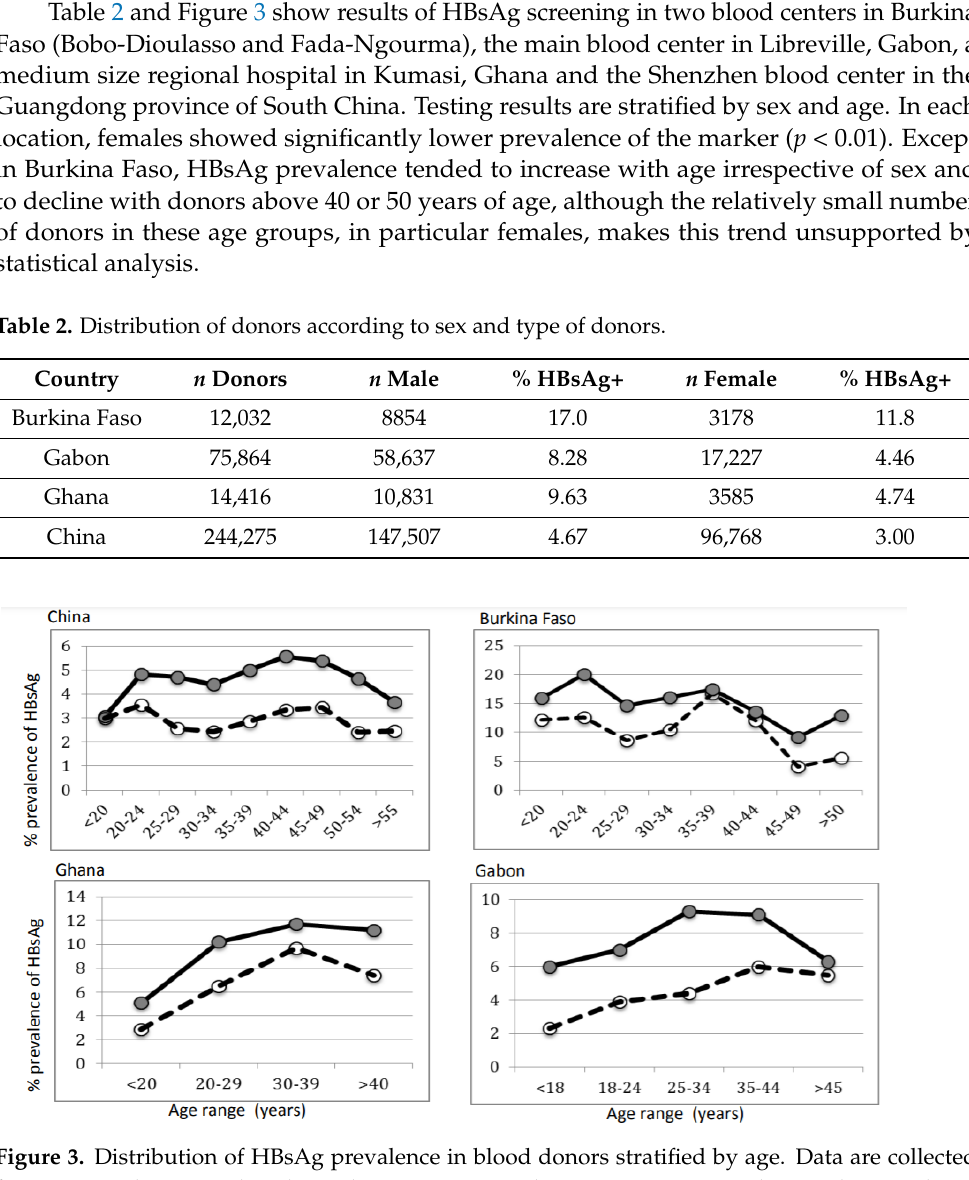
Figure 3. Distribution of HBsAg prevalence in blood donors stratified by age. Data are collected from 244,275 donors in Shenzhen, China; 12,032 in Burkina Faso; 75,864 in Gabon; and 14,416 donor samples in Ghana. Grey circles and solid line indicate male donors; open circles and dotted lines indicate female blood donors. Table 2. Distribution of donors according to sex and type of donors.